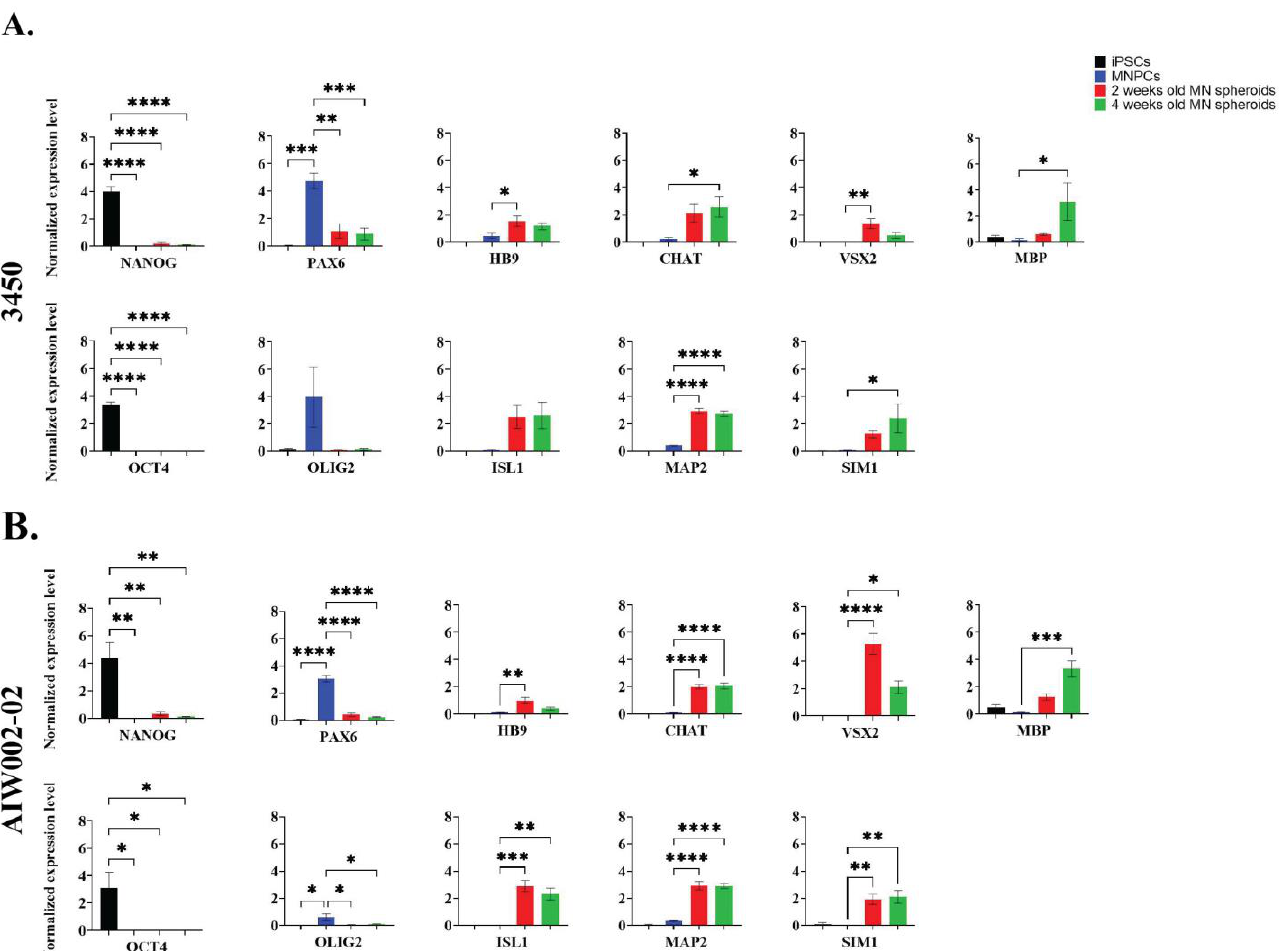
Figure 3. Transcript expression profile of iPSC-derived MN spheroids. Normalized expression levels of NANOG, OCT4, PAX6, OLIG2, HB9, ISL1, CHAT, MAP2, VSX2, SIM1, MBP, and GFAP in iPSCs, MNPCs, and iPSC-derived MN spheroids differentiated for 14 and 28 days from ( A ) 3450 and ( B ) AIW002-02 lines. Data normalized to Actβ -GAPDH expression. Bar graphs show the mean ± SEM; three MN spheroid batches per time point (14 and 28 days). Each MN spheroid batch was obtained from iPSC-derived MNPC batches at passage 3 generated through independent differen- tiation processes. Significance was determined for each gene using a one-way ANOVA. Next, post Dunnett’s tests using iPSCs (NANOG and OCT) or MNPCs (PAX6, OLIG2, HB9, ISL1, CHAT, MAP2, VSX2, SIM1, and MBP) as reference samples were performed. * p ≤ 0.05; ** p ≤ 0.01; *** p ≤ 0.001; **** p ≤ 0.0001.